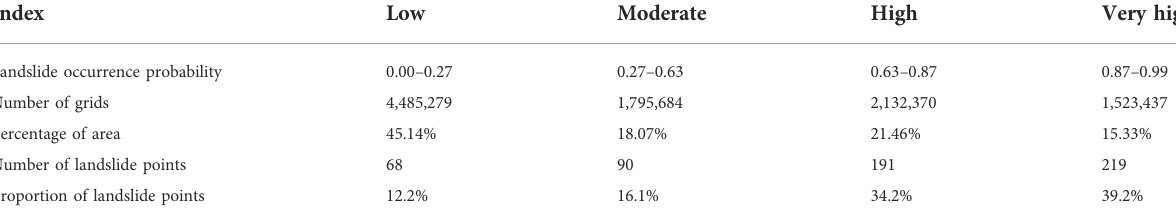
TABLE 6 Statistics on landslide susceptibility prediction